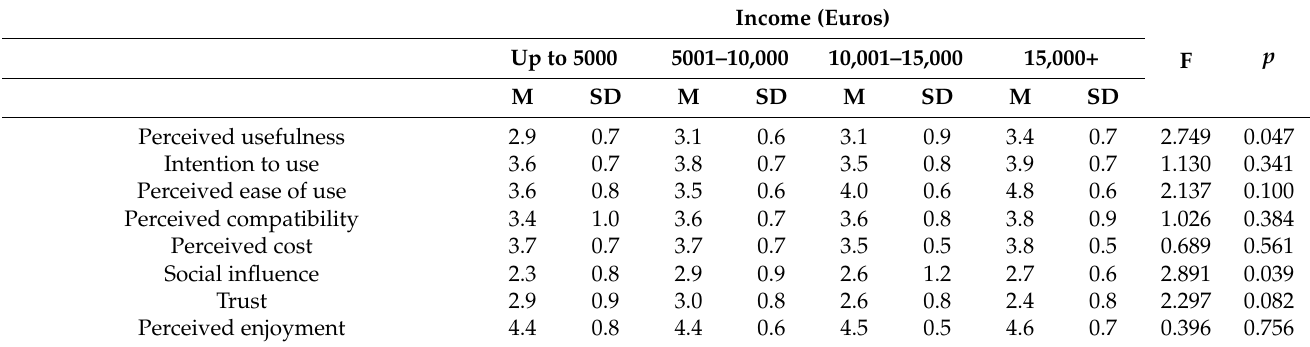
Table A16. Results of t -test for the differentiation of factors and intention to use services in relation to the annual family income.